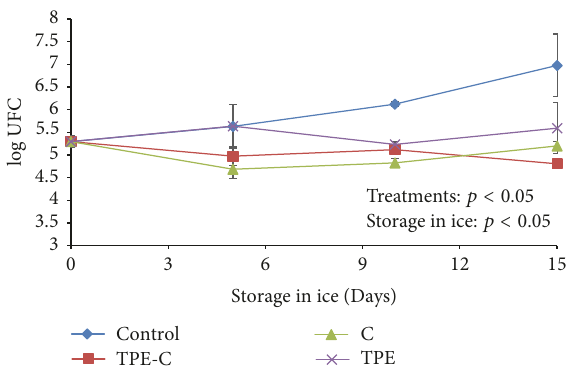
Figure 4: Microbiological changes in sierra fillets (Scomberomorus sierra) with different treatments: (a) control, (b) tomato plan extract, (c) chitosan, and (d) tomato plant extract-chitosan, stored during 15 days in ice. The values are the average of 𝑛 = 4 ± the standard